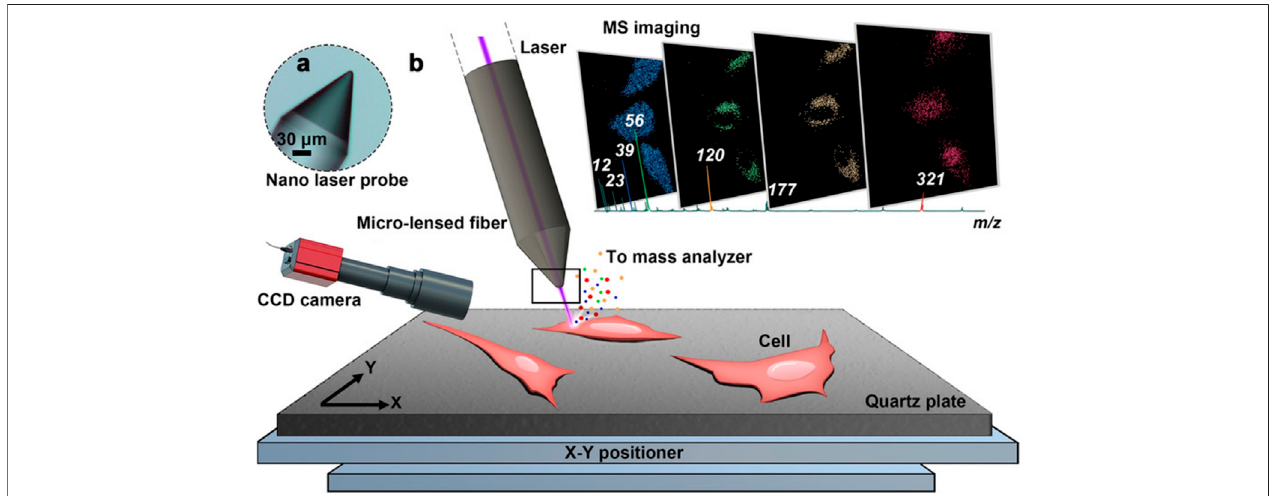
FIGURE 13 | Nano laser probe-based MSI system. (A) A microscope photograph of the tip of the nano laser probe (NLP). (B) Diagram of the ion source and MSI process (Meng et al.,